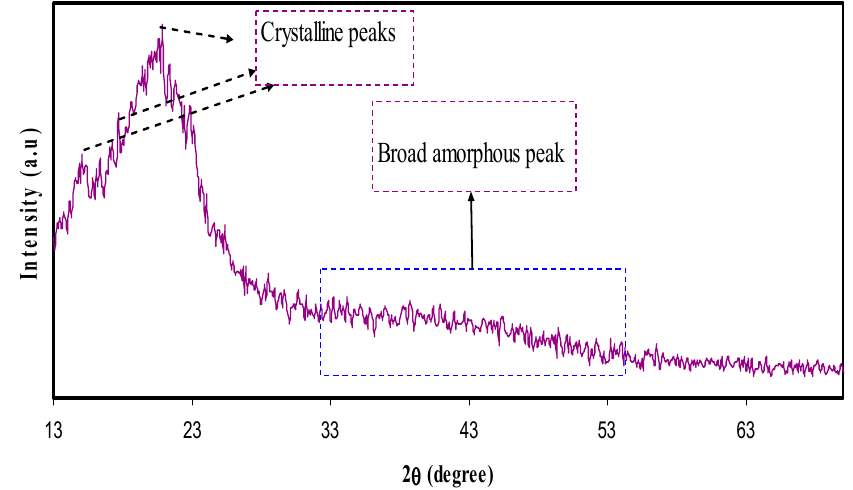
Figure 1. XRD pattern for pure chitosan (CS) film.